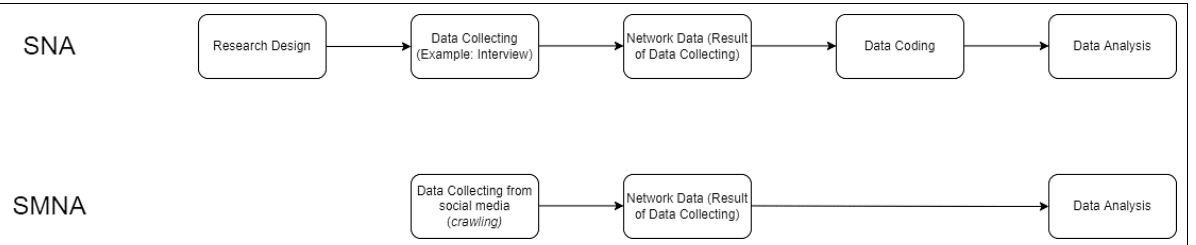
Figure 1. Differences between SNA and SMNA methodology